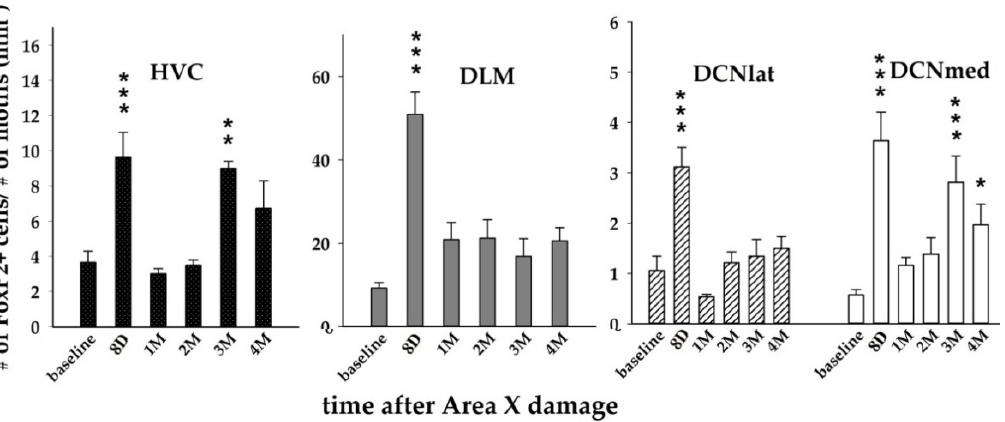
Figure 5. Quantification of the number of FoxP2+ cells in HVC, DLM, DCNlat, and DCNmed after Area X lesion. The number was normalized to the number of song motifs sung before the sacrifice. Each bar represents mean and SEM. Two-way ANOVA was followed by the Holm–Sidak test with multiple comparisons vs. the baseline group. * p < 0.05, ** p < 0.01, *** p < 0.001.